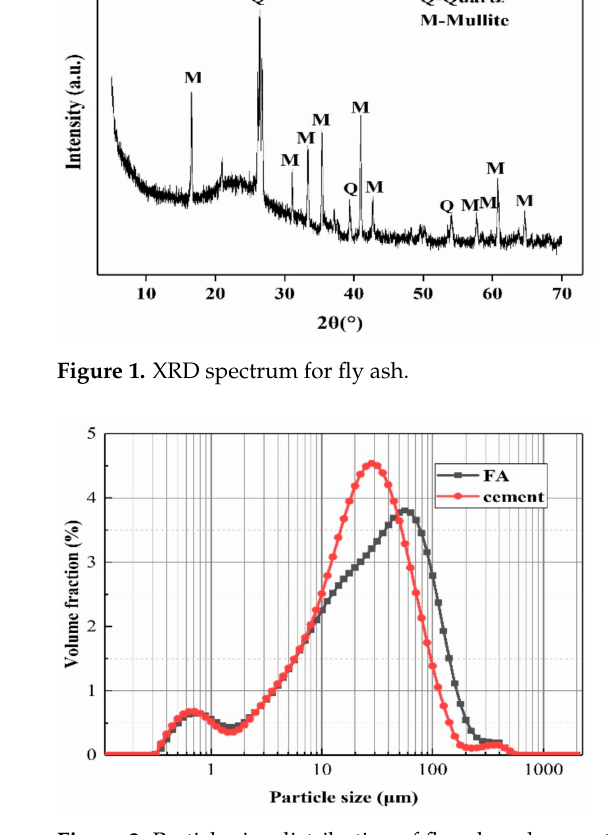
Figure 2. Particle size distribution of fly ash and